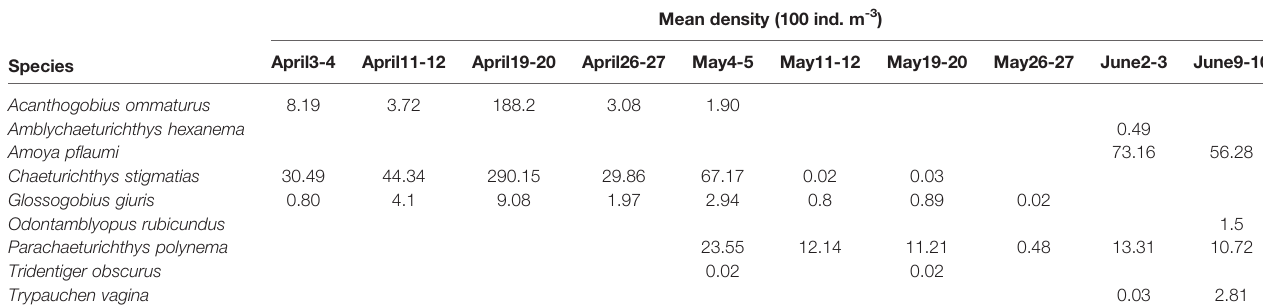
TABLE 1 | Mean density by species, expressed in individuals 100 ind. m -3 in each survey.